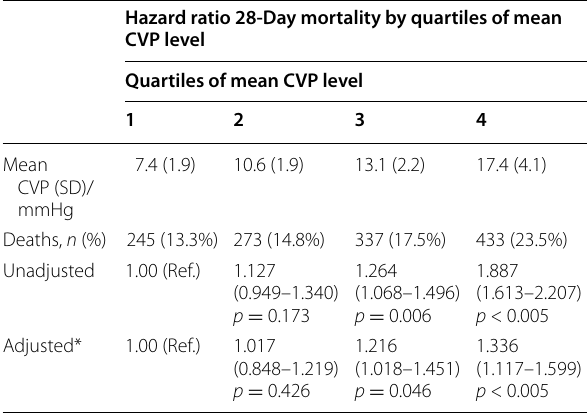
Hazard ratios (95% CI) provided. *Adjusted for sex, age, gender, ethnicity, congestive heart failure, cardiac arrhythmias, hypertension, valvular disease, pulmonary circulation disease, renal failure and other 24 Elixhauser comorbidities, ICU type, SAPS II score at admission and duration of CVP